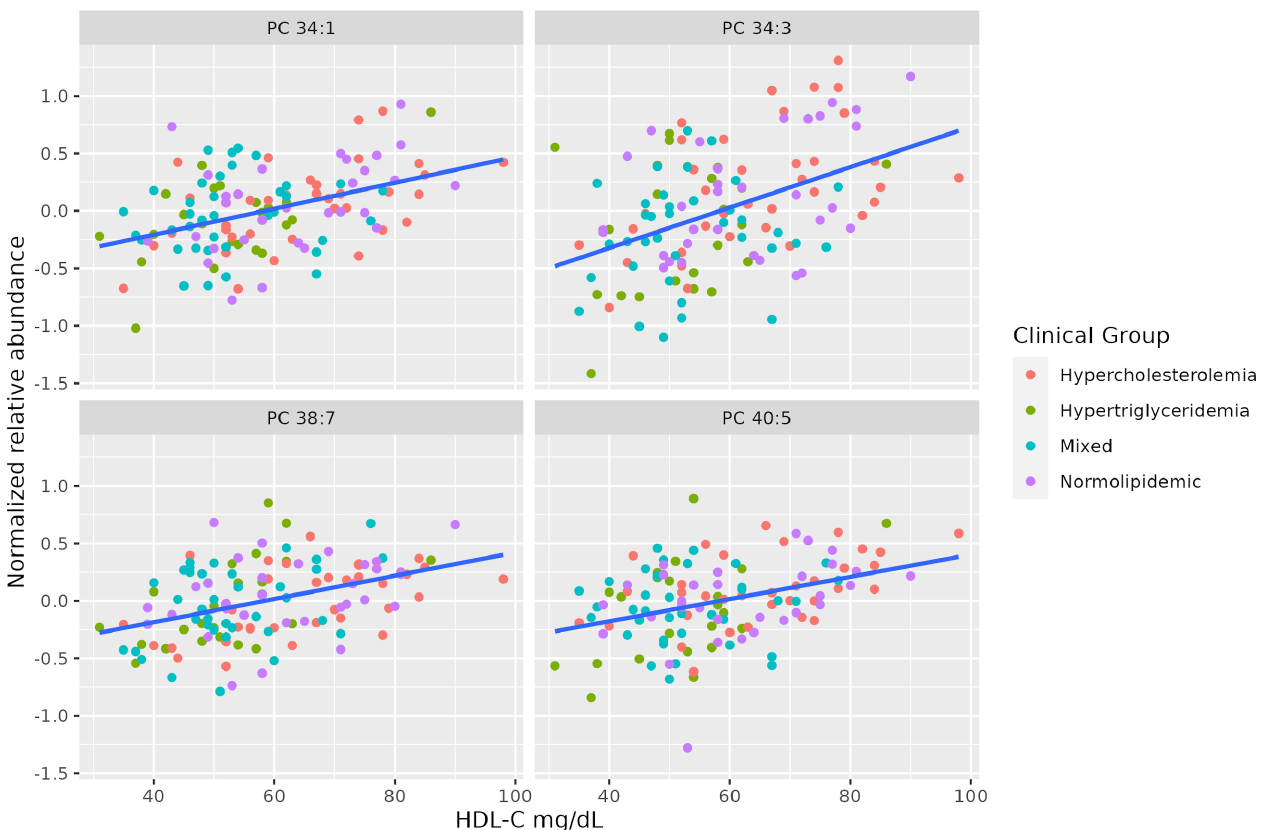
Figure 3. Dot-plot representing the correlation between serum HDL-C levels and the MS-annotated lipids. A line obtained by simple linear regression was added to aid visualization.